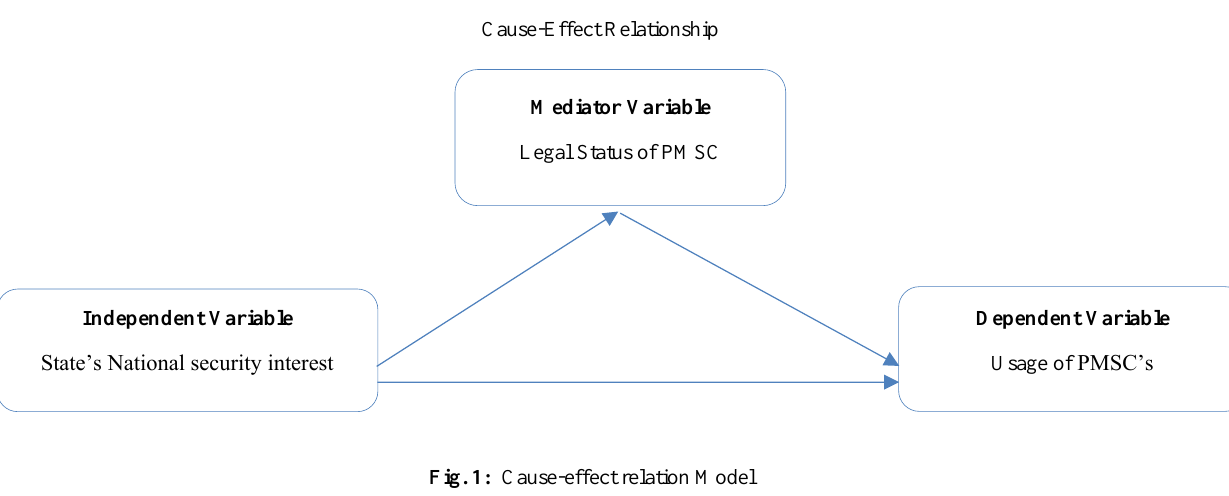
Fig. 1: Cause-effect relation